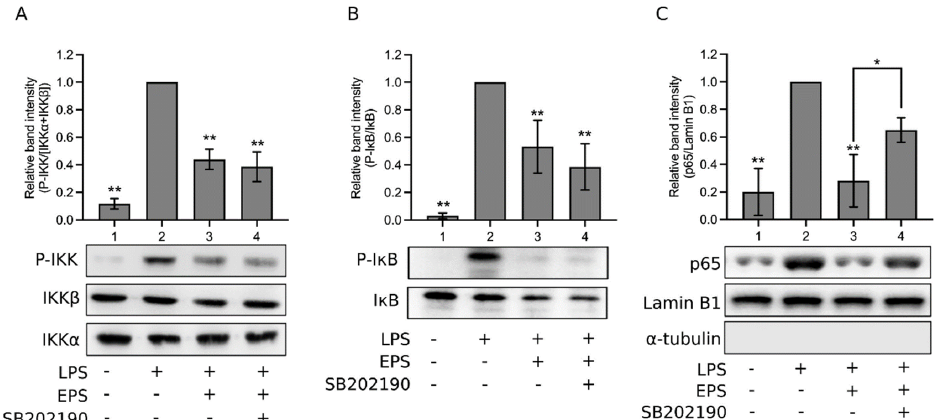
Figure 4. EPS inhibited the inhibitor kappa B kinase (IKK)/nuclear factor- κ B (NF- κ B) pathway. THP-1 cells were treated with vehicle (Lane 1), 1 μ g/mL LPS (Lane 2), LPS and 100 μ g/mL EPS (Lane 3), or LPS, EPS, and 20 μ M SB202190 (Lane 4) for 10 min ( A , B ) or 90 min ( C ). The levels of total IKK (IKK α + IKK β ) and phosphorylated IKK ( A ), total I κ B (the inhibitor of NF- κ B ) and phosphorylated I κ B ( B ), nuclear p65 subunit, as well as lamin B1 and α -tubulin ( C ), were assayed using Western blotting. Relative band intensity (normalized) vs. Lane 2 was determined. Data are presented as the mean ± standard deviation of four independent experiments. * p < 0.05 and ** p < 0.005 vs. Lane 2 or between the indicated groups. No significant difference was found between Lanes 3 and 4 of ( A ), and between those of ( B ).